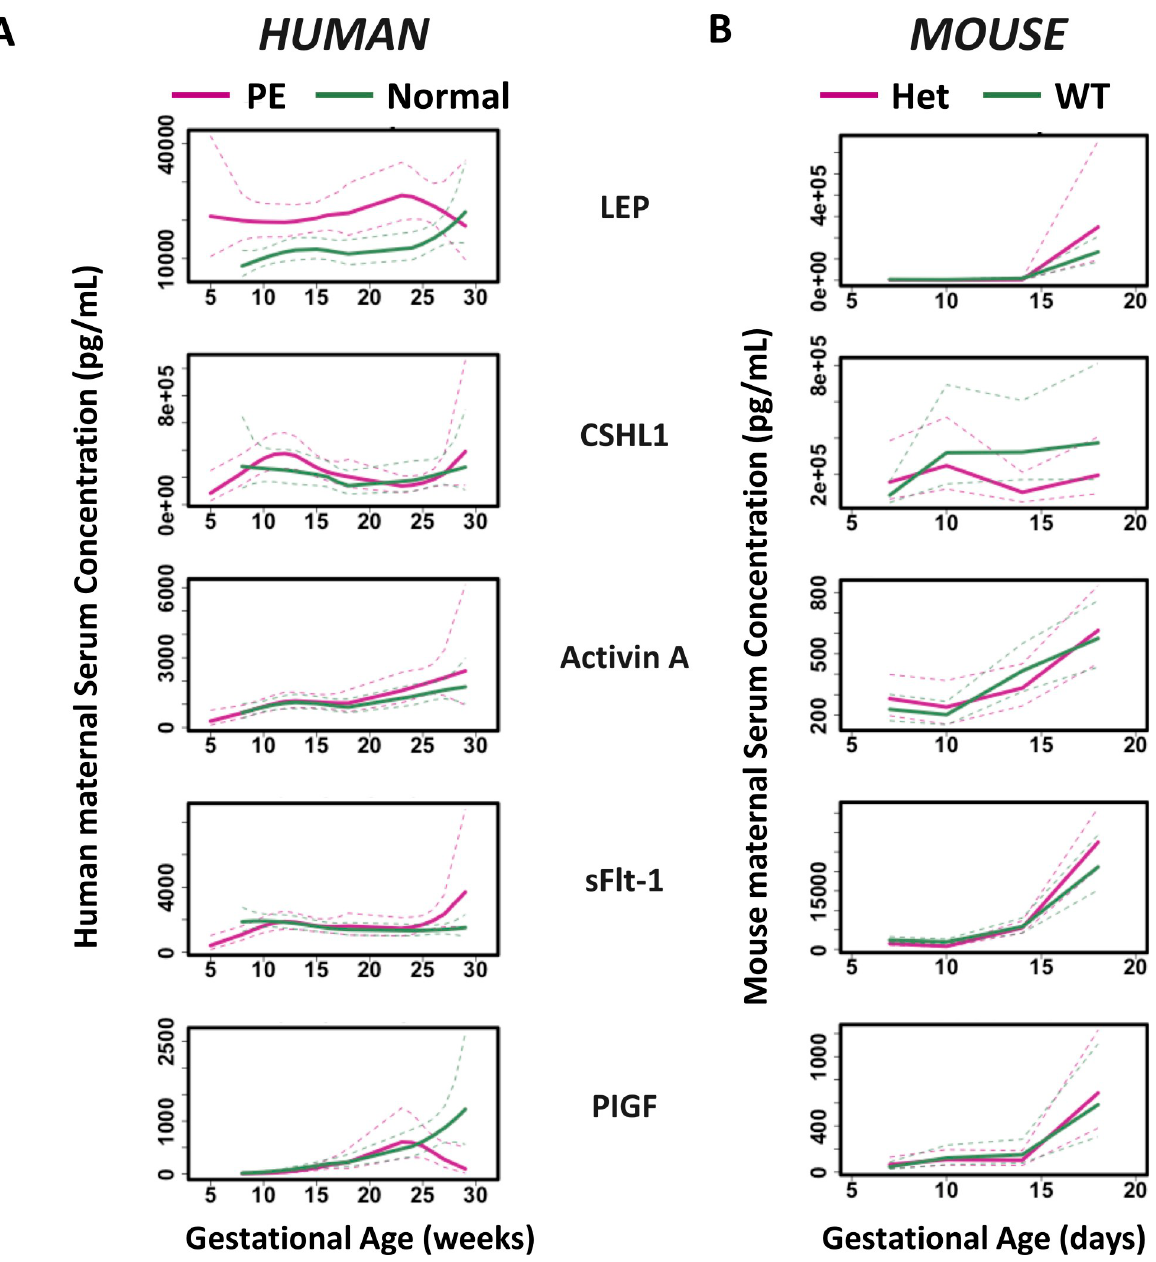
Fig 5. Loess smoothing of the serum levels of the 5 placenta-related proteins in (A) human and (B) mice as a function of GA for both normal and (A) PE or (B) HO-1 Het samples. The x axis represents GA, and the y axis represents serum concentrations. Red curves represent patterns of PE women and HO-1 Het mouse. Green curves represent patterns of normal pregnant women and WT mouse. Dotted lines represent 95% confidence intervals.